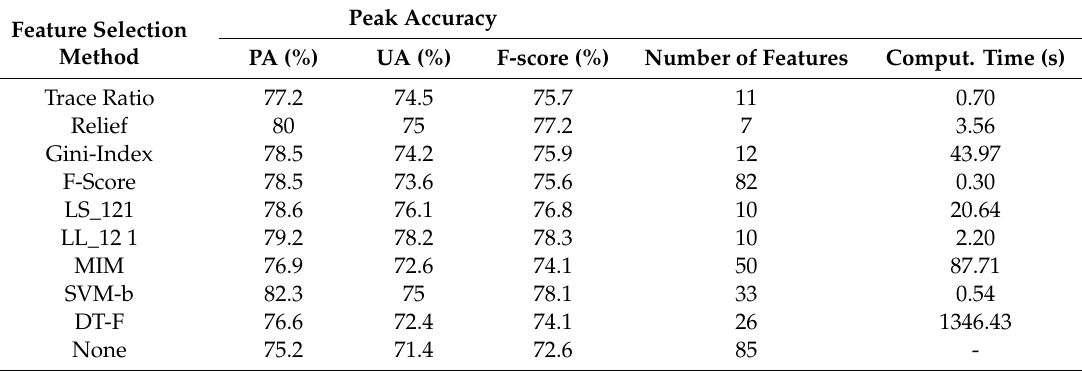
Table 6. F-score, PA and UA of Parthenium weed using optimal feature subsets yielded by investigated feature selection methods for third training